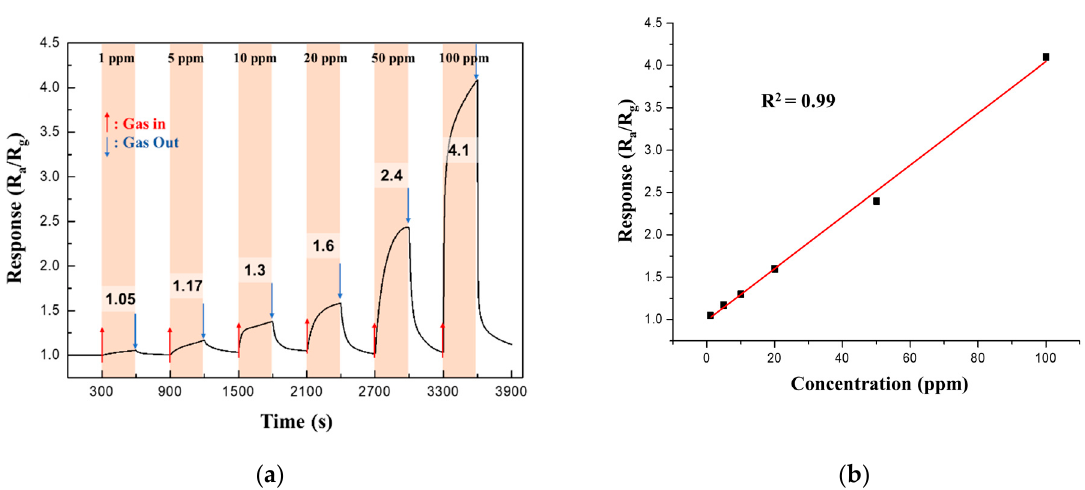
Figure 10. Response curves of 0.05 M CuO/ZnO to 100 ppm NO 2 , NH 3 , and CO gases at 250 °C.